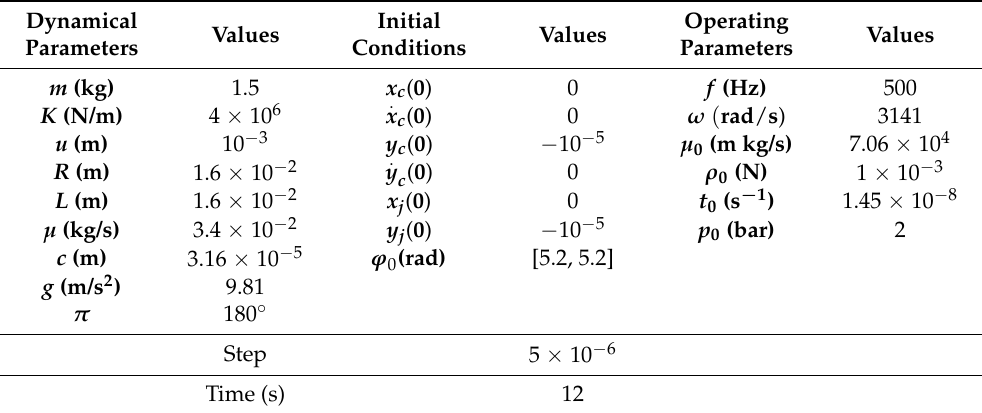
Table 2. Simulation